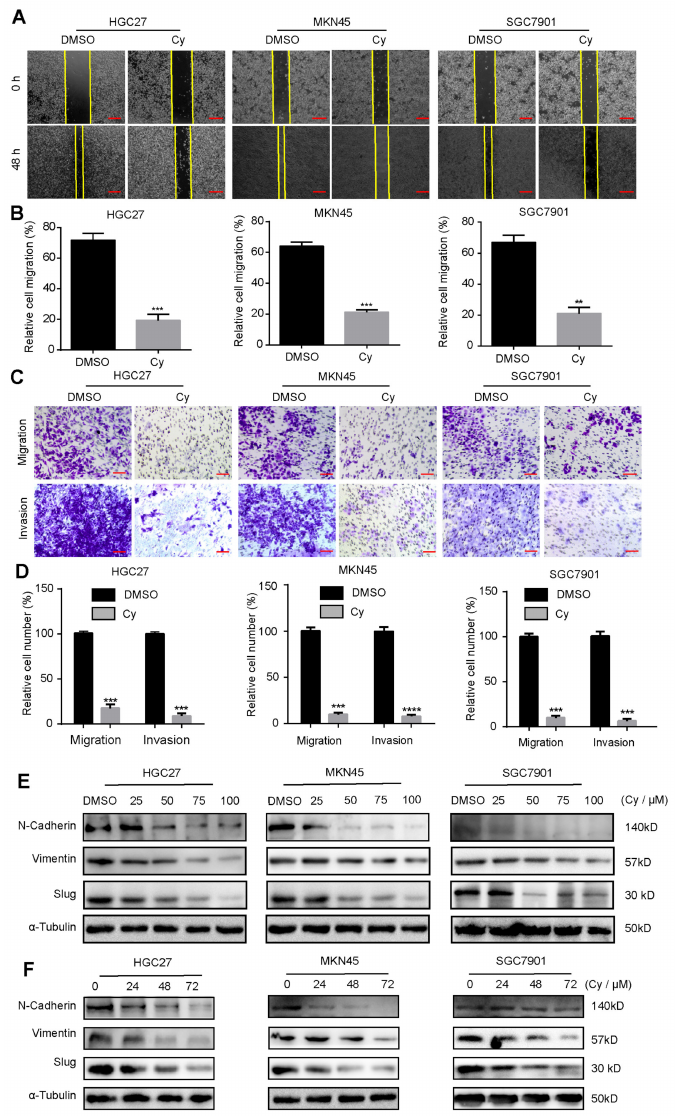
Figure 3. Cynaroside inhibits the migration and invasion of gastric cancer cells. ( A ) The